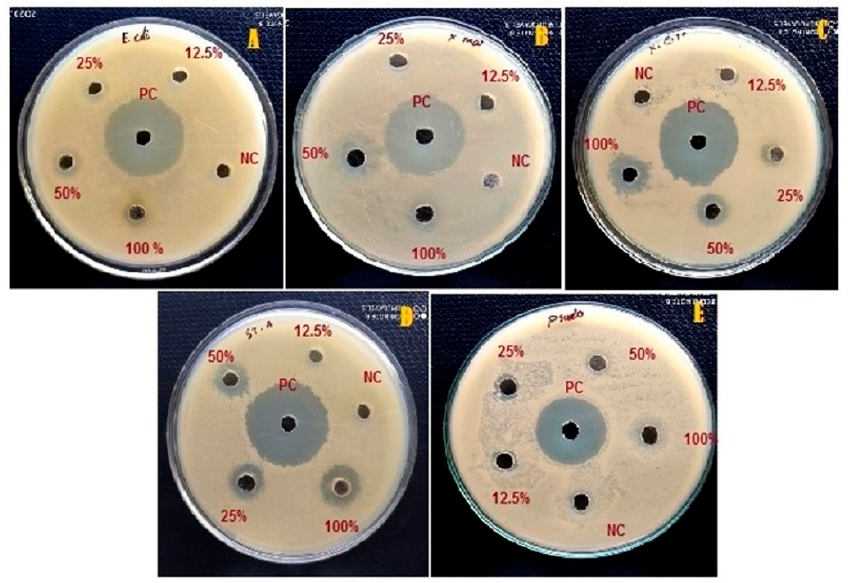
Figure 5. Impact of P. costalis foam concentrations (12.5, 25, 50 and 100%) on the growth of Escherichia coli ( A ), Xanthomonas malvacearum ( B ), Xanthomonas citri ( C ), Staphylococcus aureus ( D ) and Pseudomonas fluorescens ( E ).